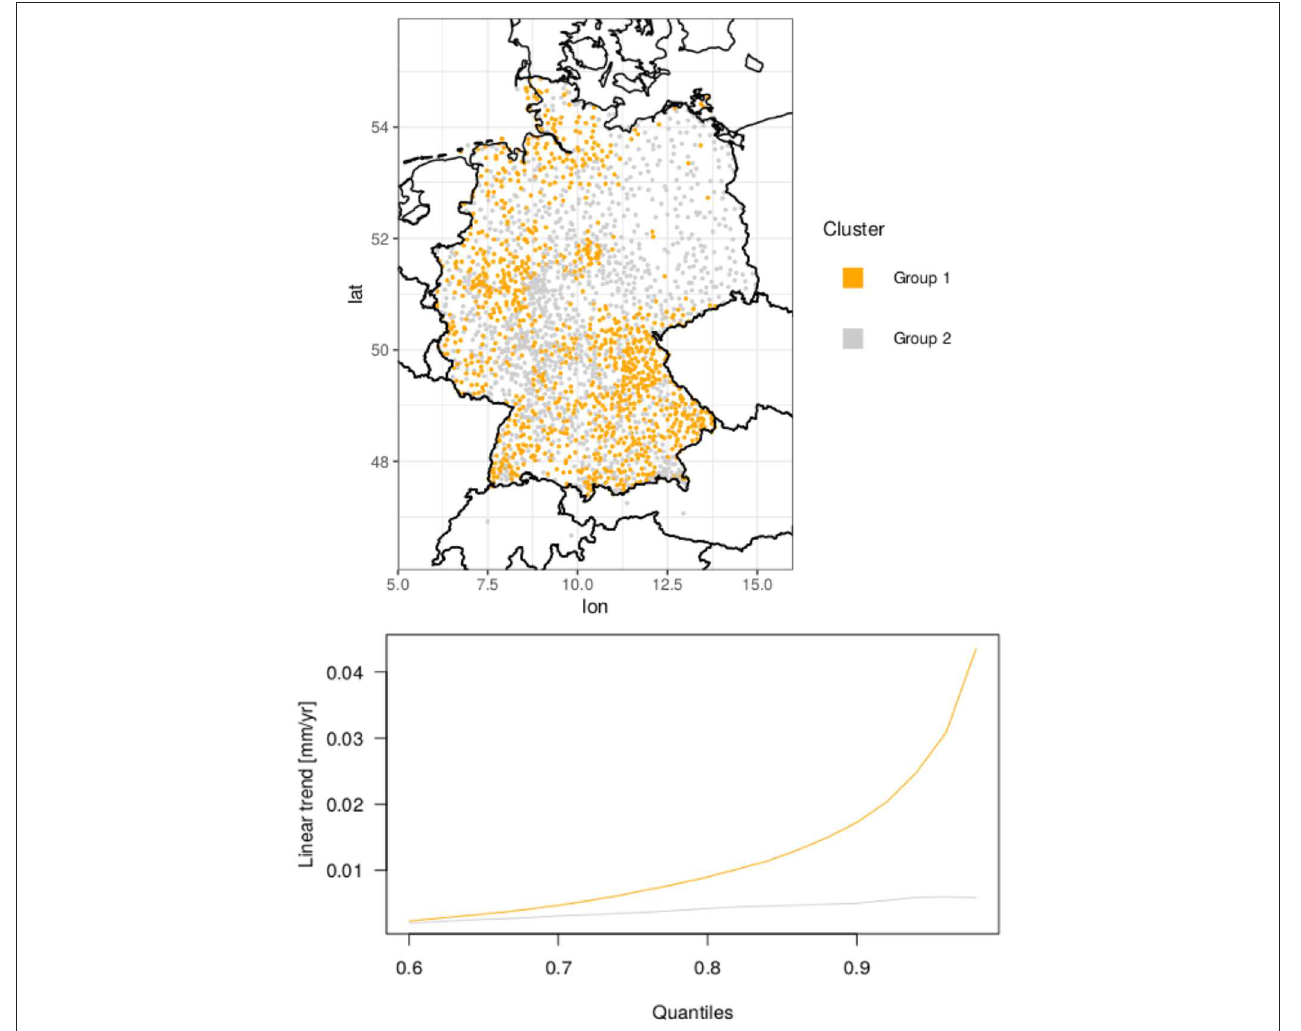
FIGURE 7 | Resulting k -means clusters (Upper) with corresponding centers (Lower) represented by the mean QR trend curves for quantiles from 0.6 to 0.98. The color of each group applies to both